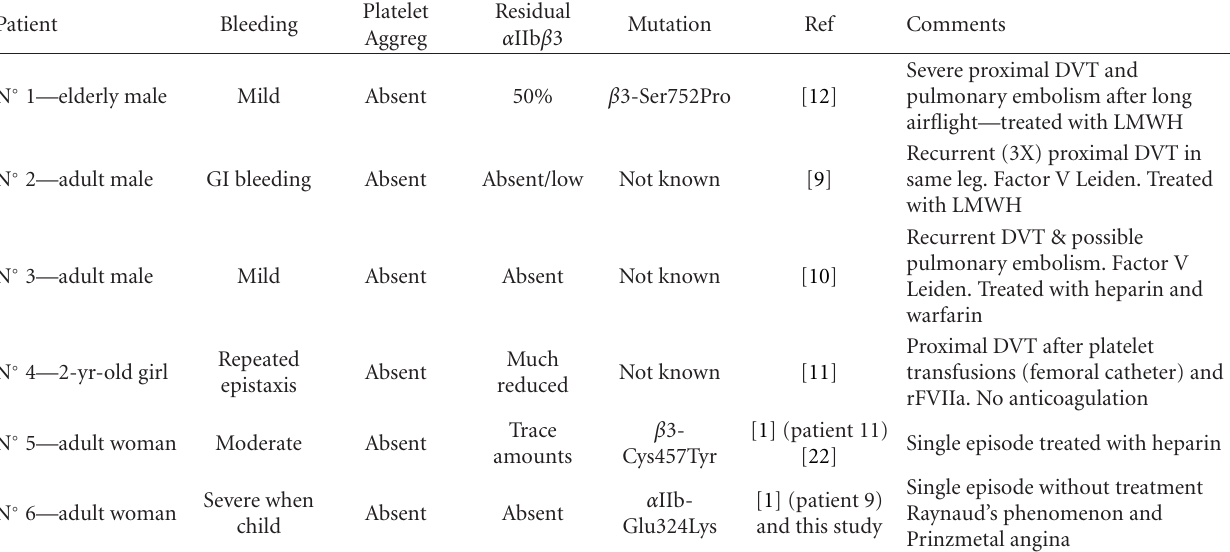
Table 1: Patients with DVT described in the literature and this